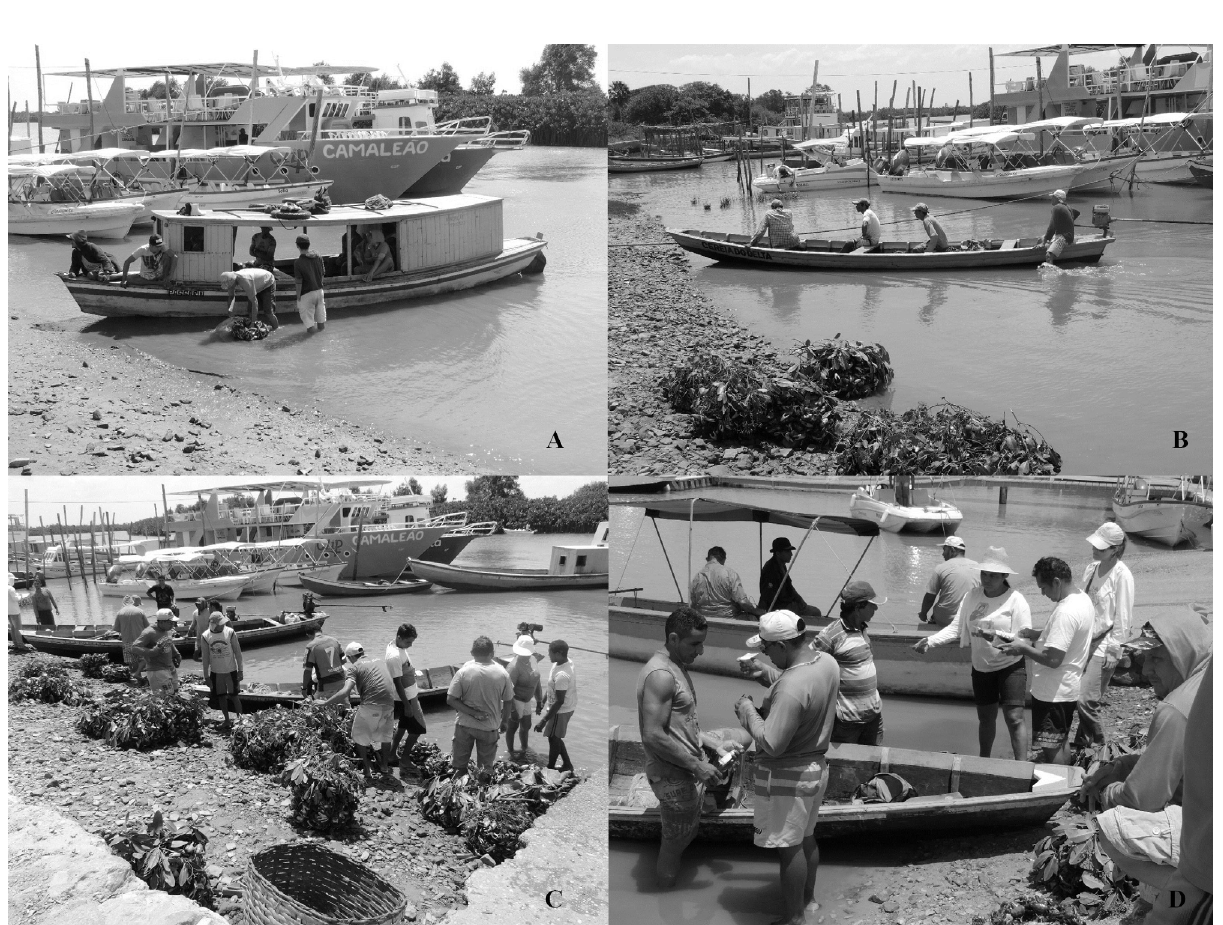
Figure 1. Details of the commercialization of Ucides cordatus . A) Larger vessel arriving at the Tatus harbor; B) Small vessel (more common) arriving in the harbor; C) Negotiations between traders and gatherers with exposure of collected crab; D) Payment of the product (detail of the merchants offering predetermined amounts to the gatherers). Photos: F.H.S.